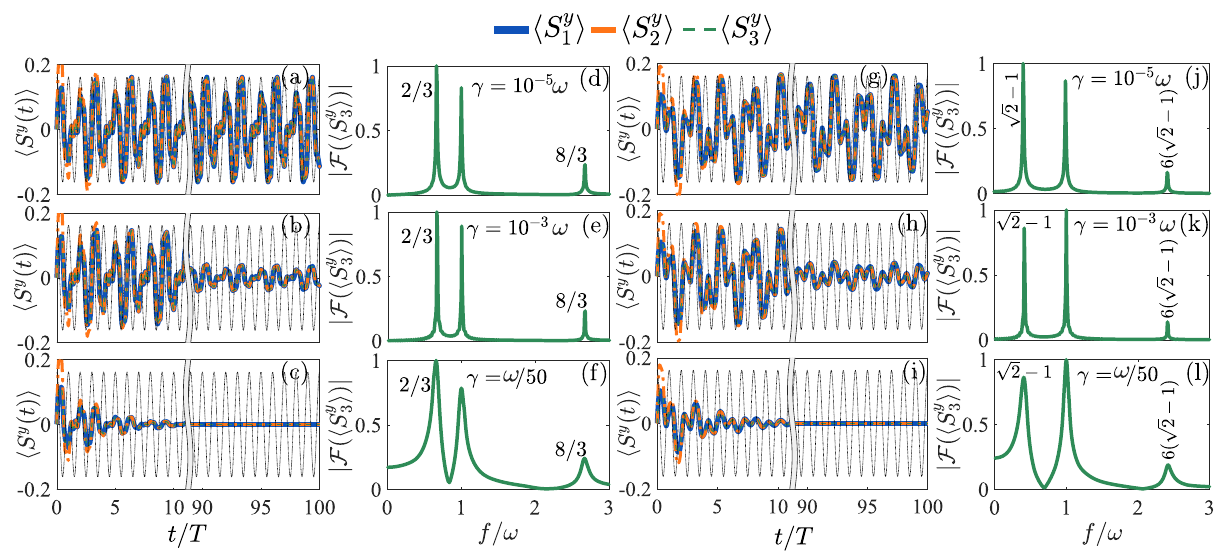
Fig. 4 discrete time crystal (DTC) and discrete time quasi-crystal (DTQC) oscillations. Time evolution of h S y j ð t Þi [ j = 1 (blue solid lines), j = 2 (orange dot-dashed lines), j = 3 (green dashed lines)] as a function of the dimensionless time t / T showing the appearance of DTC in the long-time limit for three values of system-lead couplings, ( a ) γ = 10 − 5 ω , ( b ) γ = 10 − 3 ω , and ( c ) γ = ω /50. Black dotted line represents cos ð 2 π t T Þ , the driving period. d – f Discrete Fourier transform (DTF) F ðh S y iÞ of h S y ð t Þi as a function of the frequency domain variable f / ω corresponding to ( a – c ), respectively, showing the λ = 2 ω /3. 3 3 Time evolution of h S y j ð t Þi ( j = 1, 2, 3) as a function of the dimensionless time t / T showing the appearance of DTQC in the long-time limit for three values of system-lead couplings, g γ = 10 − 5 ω , ( h ) γ = 10 − 3 ω , and i γ = ω /50. j – l DFT of h S y ð t Þi as a function of the frequency domain variable f / ω corresponding to ffiffiffi p 3 ( g – i ), respectively, showing the λ ¼ ð 2 (cid:2) 1 Þ ω . There exists another frequency at an integer multiple of the DTC (and DTQC) frequency in the form of a tiny peak in DTF above ω